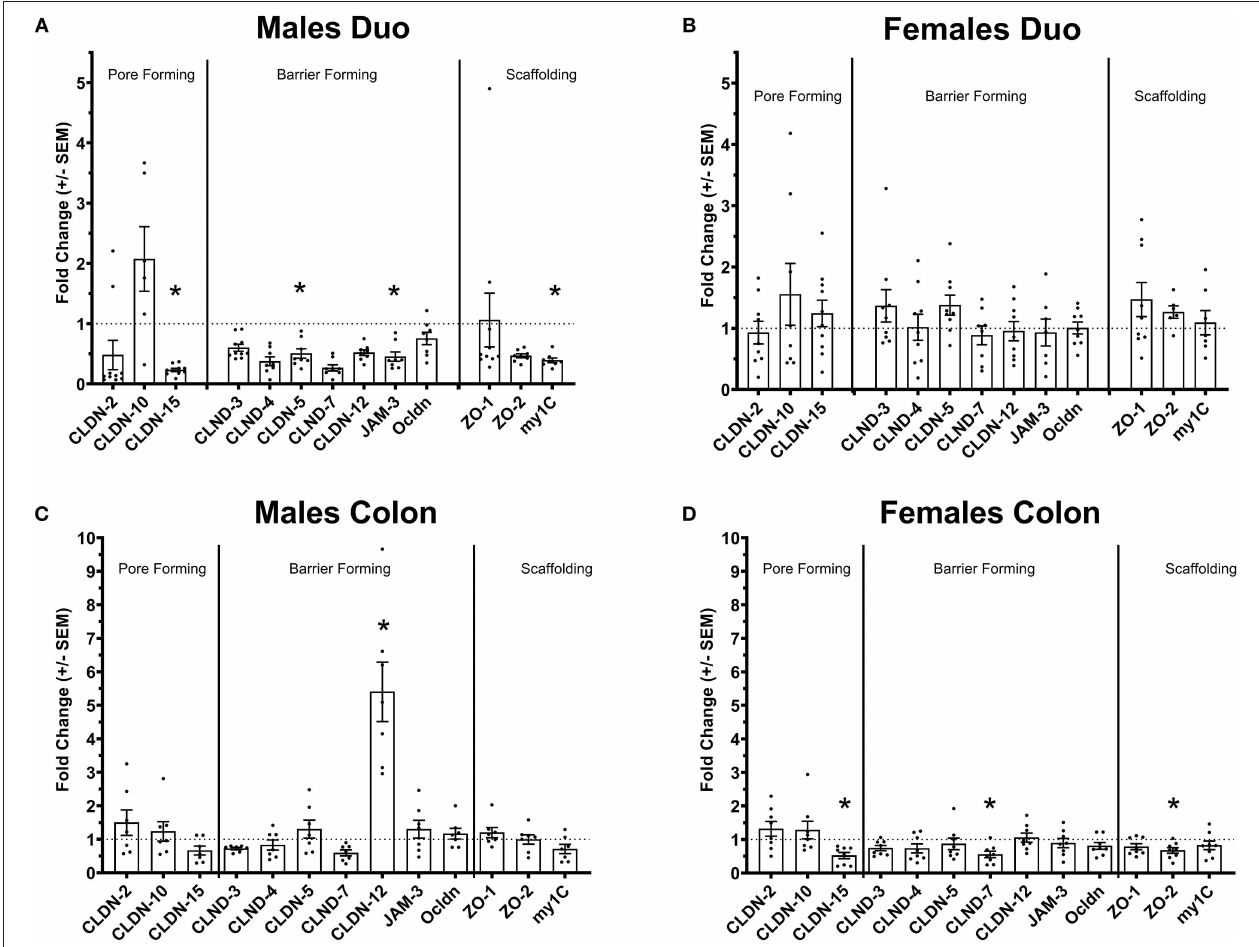
FIGURE 1 | Tight-junctions gene expression profile in the intestine of Ztm. (A) Down regulated tight-junction genes in the duodenum Ztm males ( n = 6–10). (B) Unaltered tight-junction profile in the duodenum of Ztm females ( n = 7–12). (C) Increased CLDN-12 in the colon of Ztm males ( n = 7). (D) Downregulation of tight junction genes in the colon of Ztm females ( n = 8). mRNA expression was analyzed by qPCR, normalized to WT, and expressed as fold regulation. Statistical analysis was performed by the non-parametric Mann-Whitney test comparing each gene to its WT counterpart. * p <